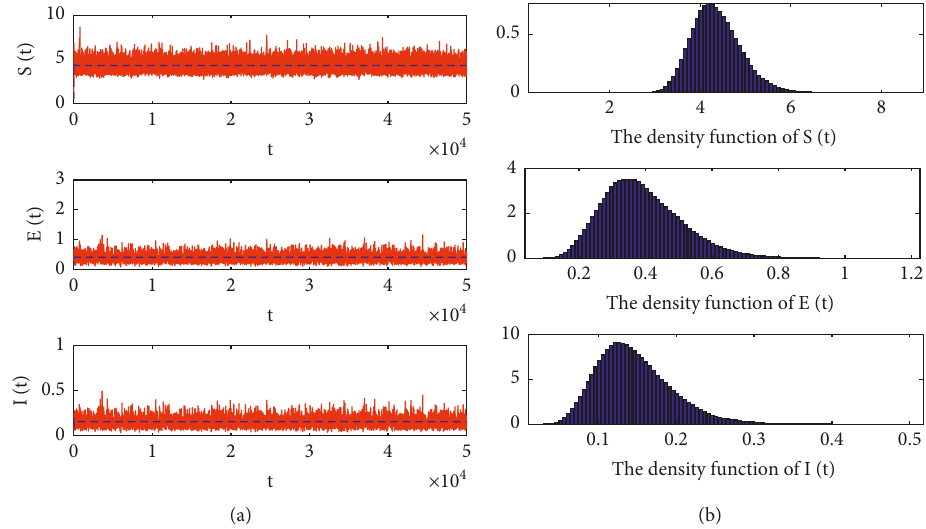
Figure 1: (a) The red line describes the solution about the stochastic system, and the blue line describes the solution about the deterministic system. (b) The density function of the